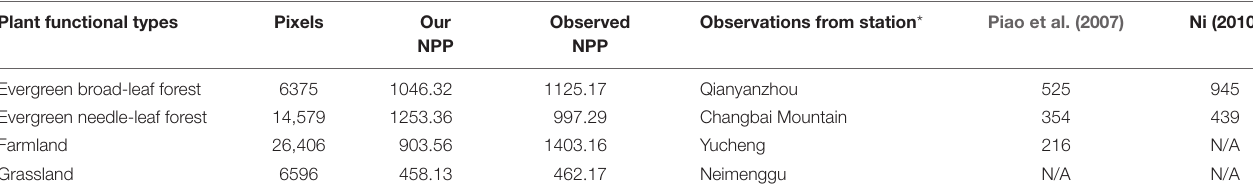
TABLE 1 | A comparison of derived NPPs using CASA model of this study with previous studies and eddy covariance tower data for the year of 2005 (unit: gC/m 2 /yr). Plant functional